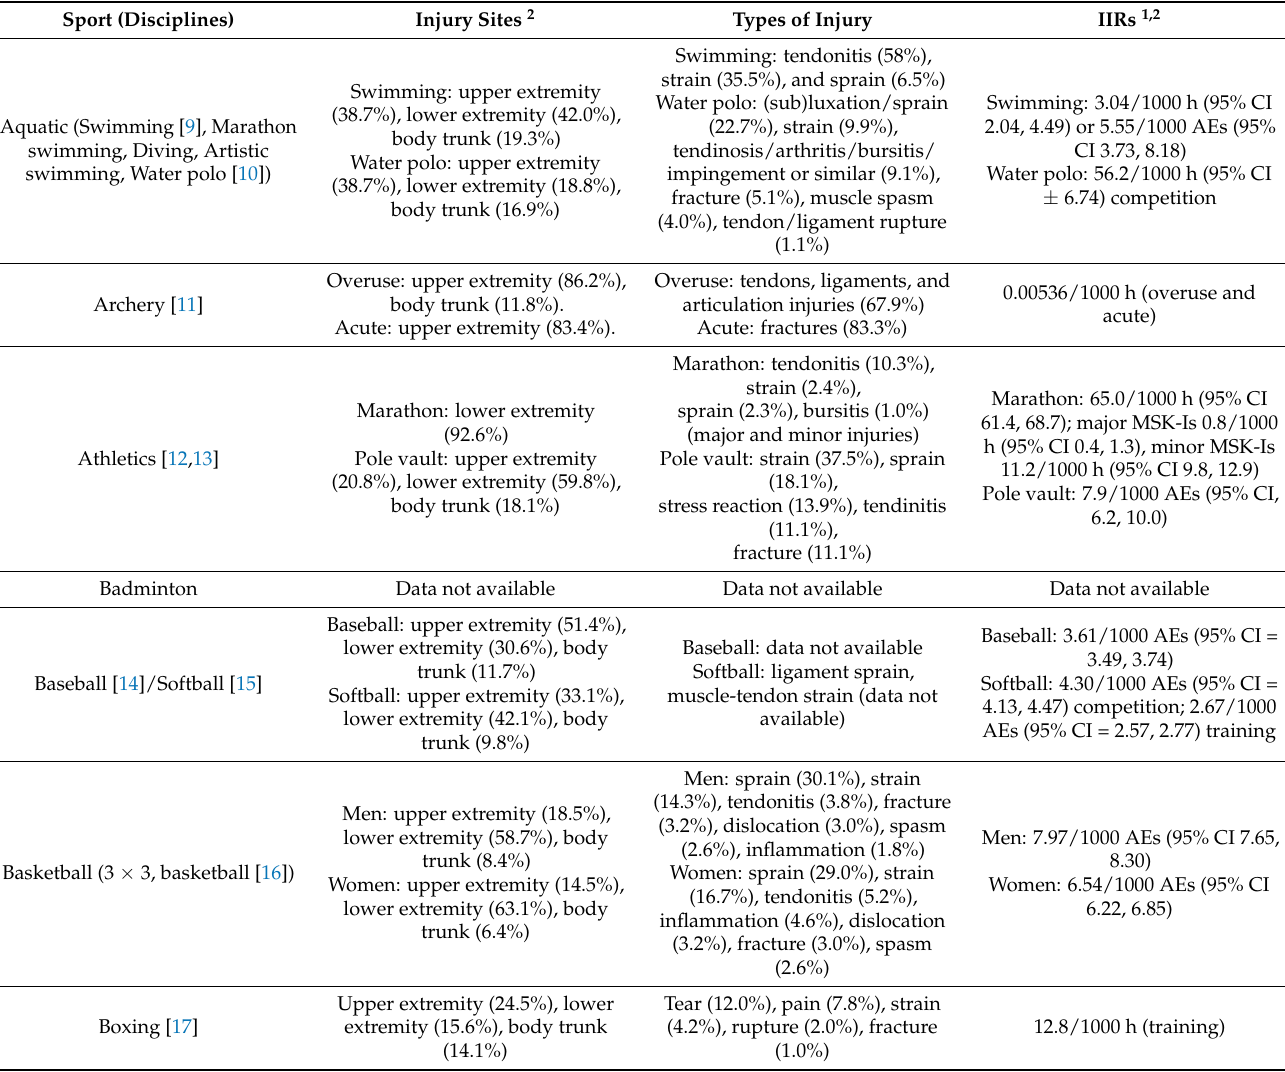
Table 1. MSK-Is in Olympic